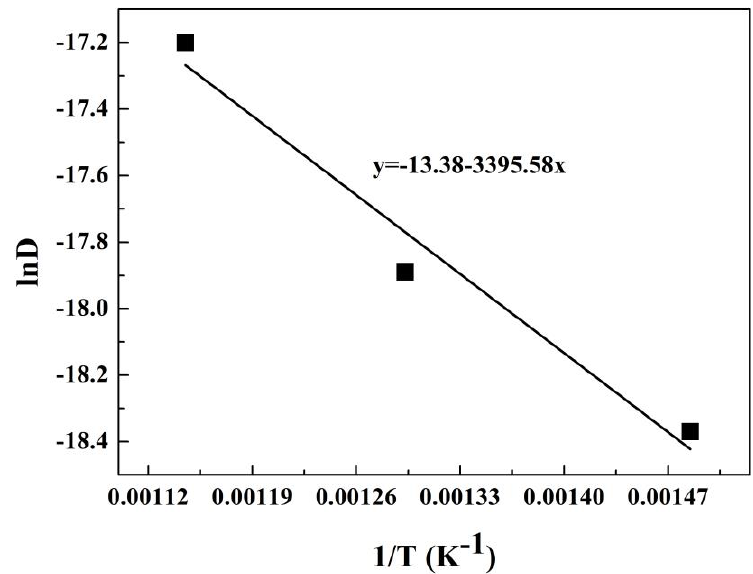
Figure 6. Relationship of ln D and 1/ T .